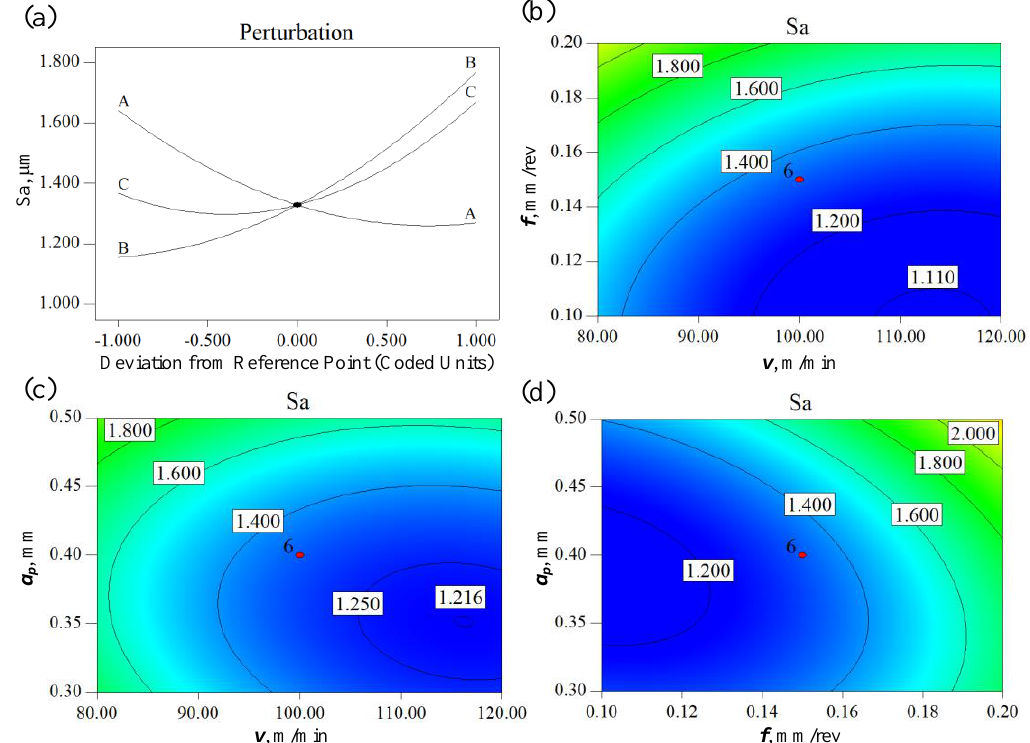
Figure 9. E ff ect of cutting parameters on surface roughness. ( a ) Perturbation plot of the e ff ect of cutting parameters on surface roughness, ( b ) contour plot of the e ff ect of cutting speed and feed on surface roughness, ( c ) contour plot of the e ff ect of cutting speed and depth of cut on surface roughness, ( d ) contour plot of the e ff ect of feed and depth of cut on surface roughness.